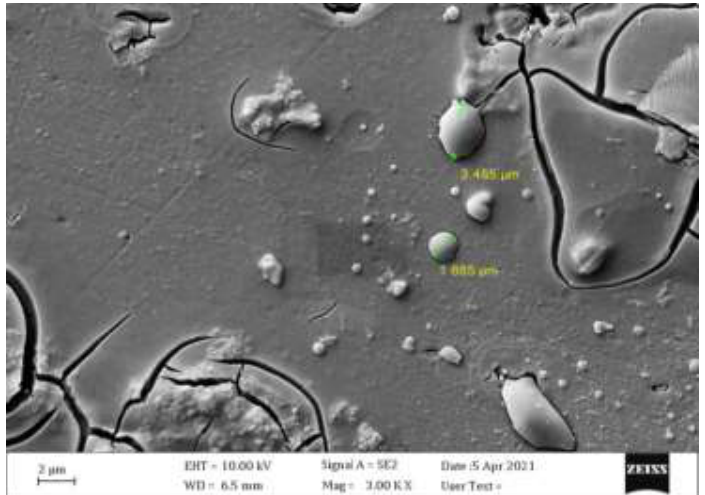
Figure 7: SEM images after inhibition with two inhibitors in HCl medium.